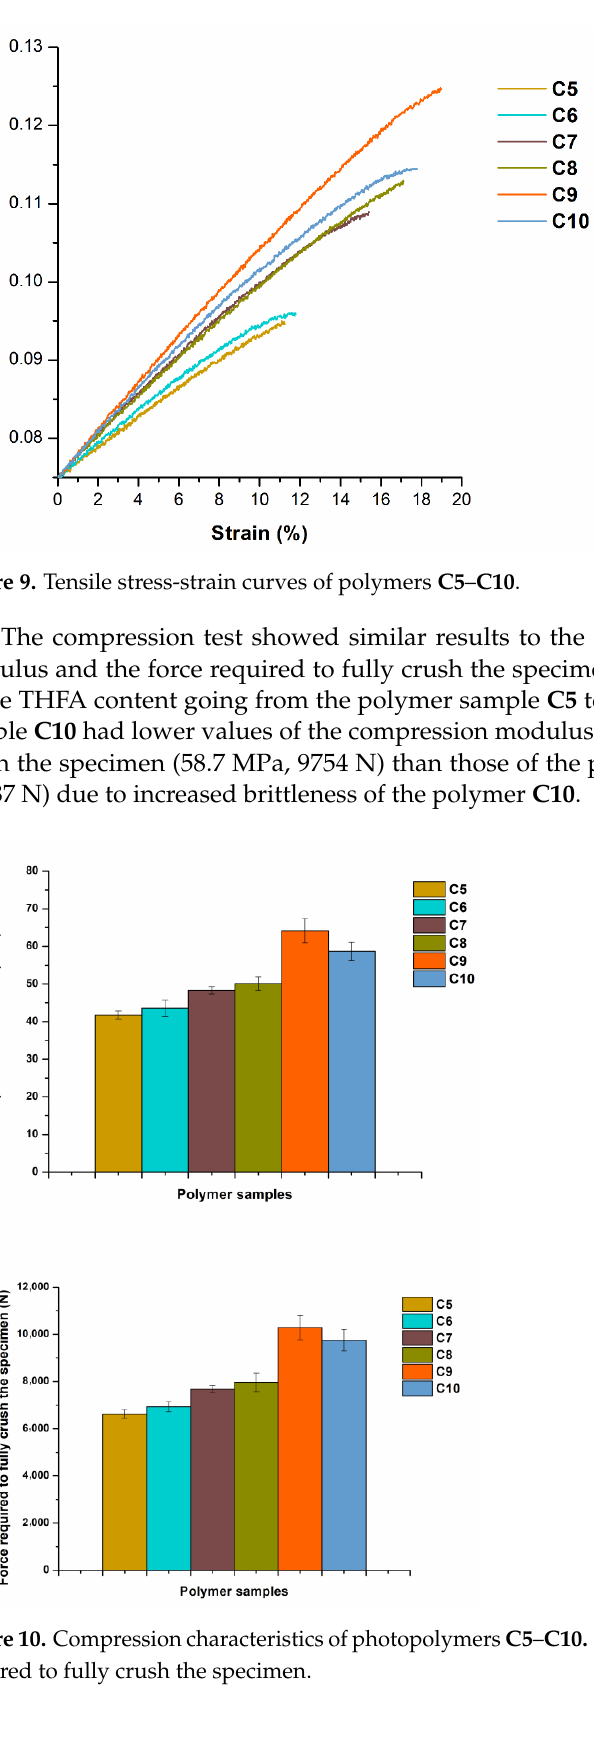
Figure 8. Tensile characteristics of polymers C5 – C10 . ( a ) Young’s modulus , ( b ) tensile strenght, ( c ) elongation at break.